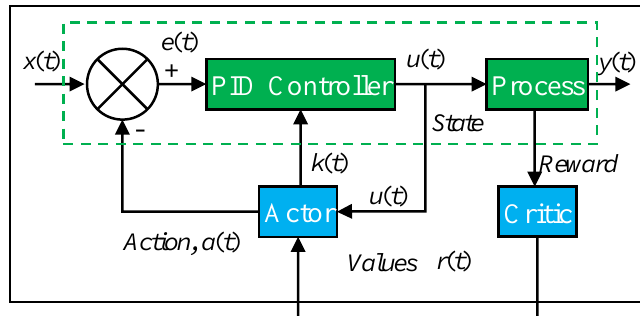
Figure. 1. PID-SARSA Reinforcement